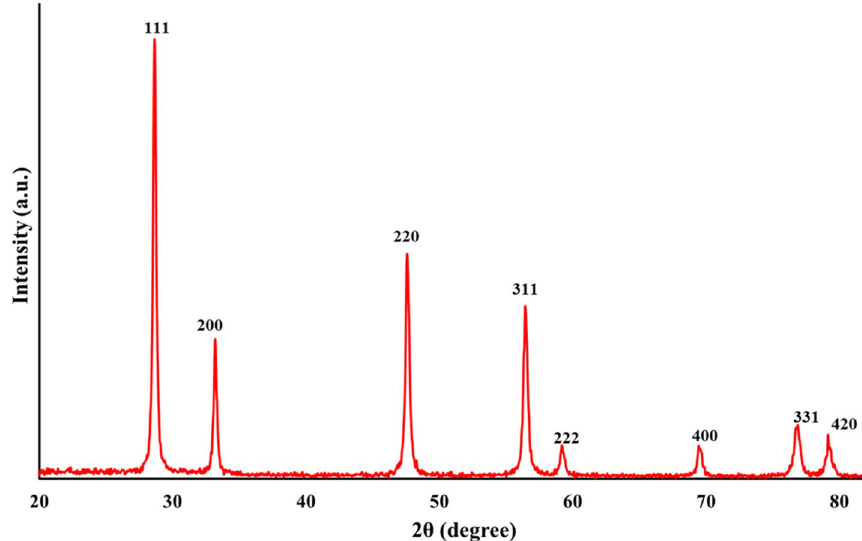
Figure 4. XRD pattern of the marine Oyster assisted biosynthesized CeO 2 NPs.